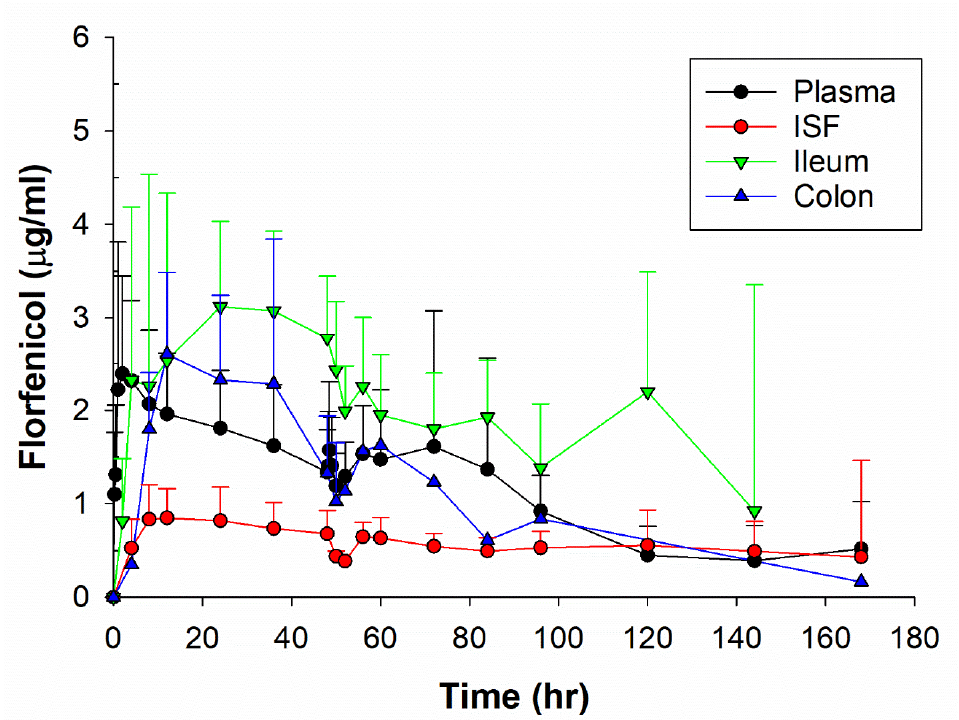
Figure 2. The drug concentration of florfenicol over time for plasma, interstitial fluid, ileum, and colon ultrafiltrate for the steers administered 20 mg/kg of florfenicol intramusculary every 48 h twice. The points represent the means with standard error bars.